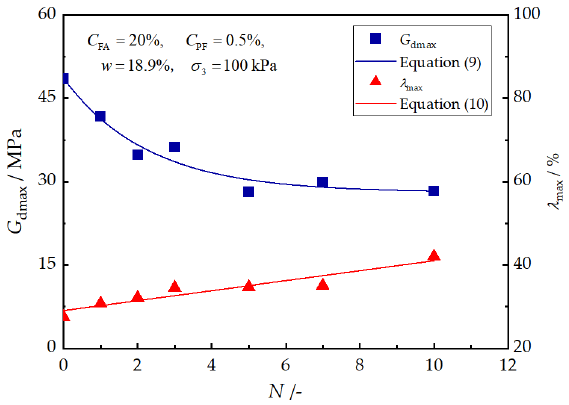
Figure 10. Effects of freeze–thaw cycle on G dmax and λ max . Figure 11 depicts the variations in G dmax and λ max caused by the FA content. As shown, G dmax keeps increasing near-linearly from 20.2 MPa to 32.5 MPa, achieving an increase of 60% when the FA content is increased from 0% to 30%. Similarly, λ max exhibits a linearly increasing tendency from 44.85% to 32.11% with the FA content. The following equations are used to describe these relationships: